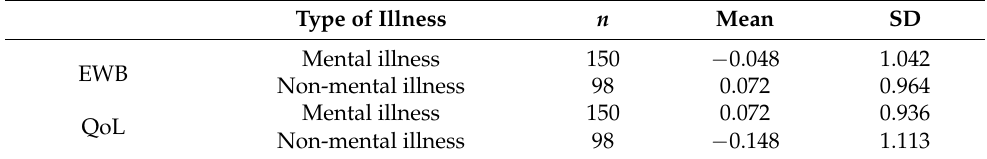
Table 12. Difference of means according to the type of illness (mental illness vs. non-mental illness).